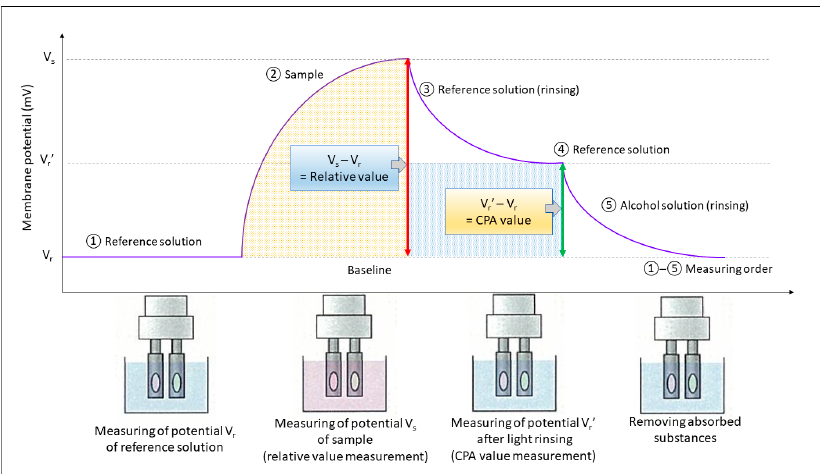
Figure 1. Measurement diagram. The relative value is the initial taste at sensory evaluation, including sourness, saltiness, and umami. The CPA value is the adsorption of bitter and astringent substances. Note: the reference solution should be tasteless or at low concentration than the tested sample. Adopted from Kobayashi, Habara, Ikezazki, Chen, Naito, and Toko